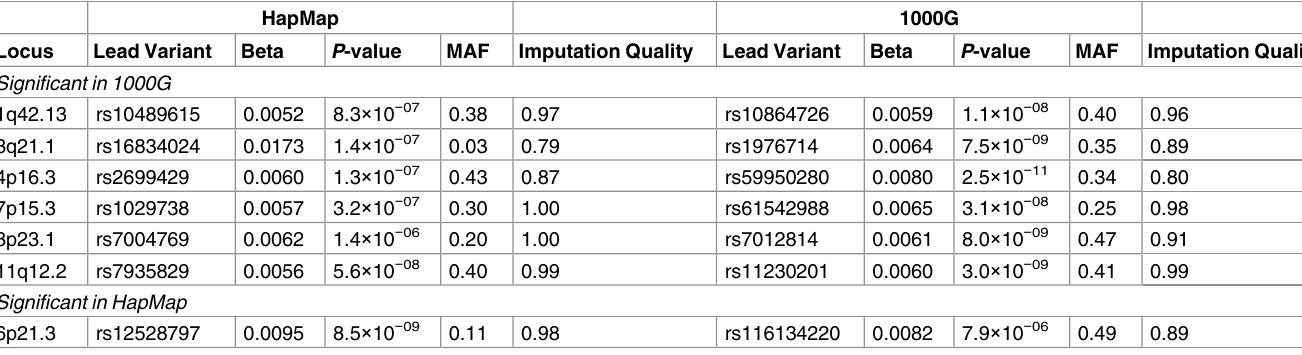
Table 1. Non-overlapping loci that were significant in either the HapMap or 1000G GWA studies.